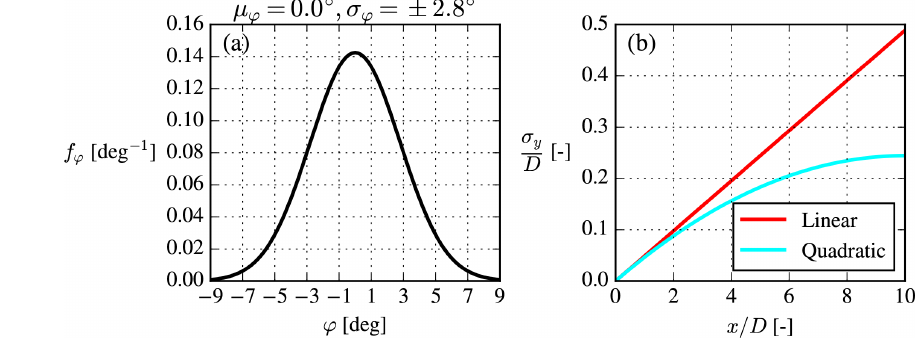
Figure C1. (a) Gaussian wind direction distribution and (b) the Gaussian filter width for the convolution with σ ϕ = 2 . 8 ◦